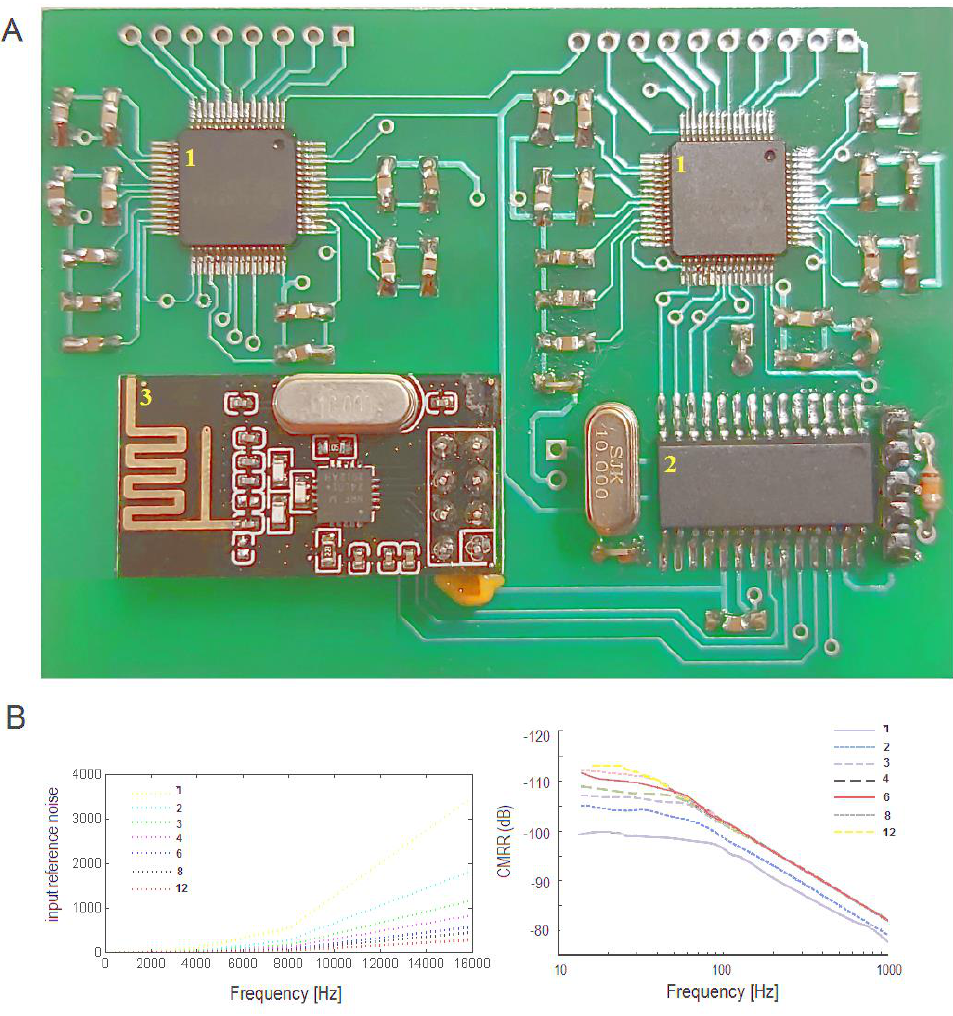
Figure 1. (A ) View of 16 channel device. ( B ) Average input reference noise μV pp of channel at sampling frequencies Fs of 250 – 16,000 Hz and gain PGA of 1 – 12 (common-mode rejection ratio (CMRR)) at said sampling frequencies.